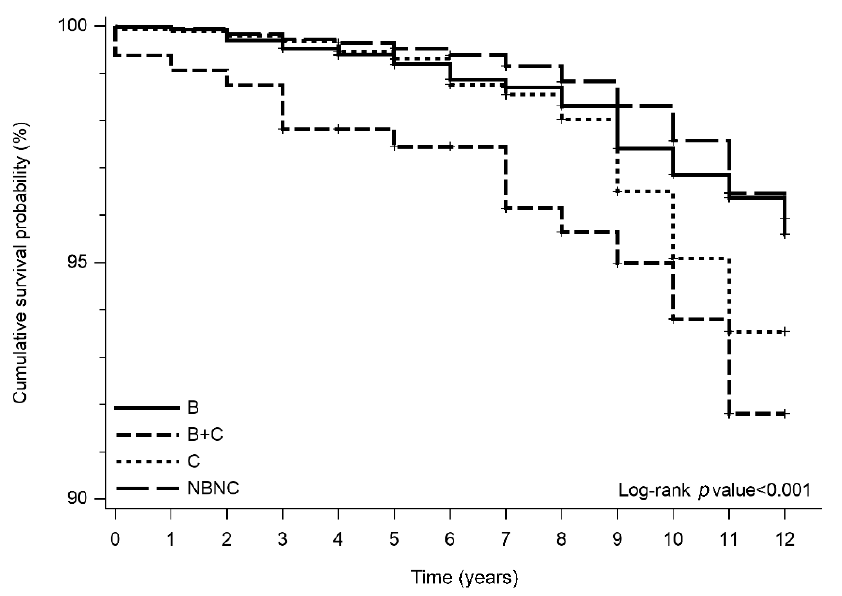
Figure 3. Cumulative survival probability stratified by etiology.